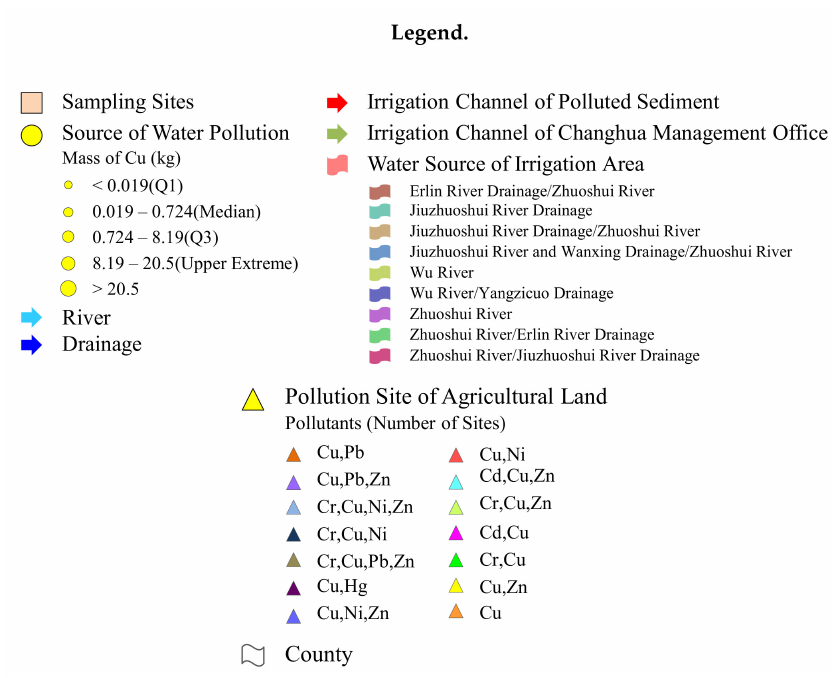
Figure 9. Distribution of the sediment and agricultural land pollution sites as well as possible pollution sources in Changhua County. Table 3. Summary of the sediment and agricultural land pollution sites of different water